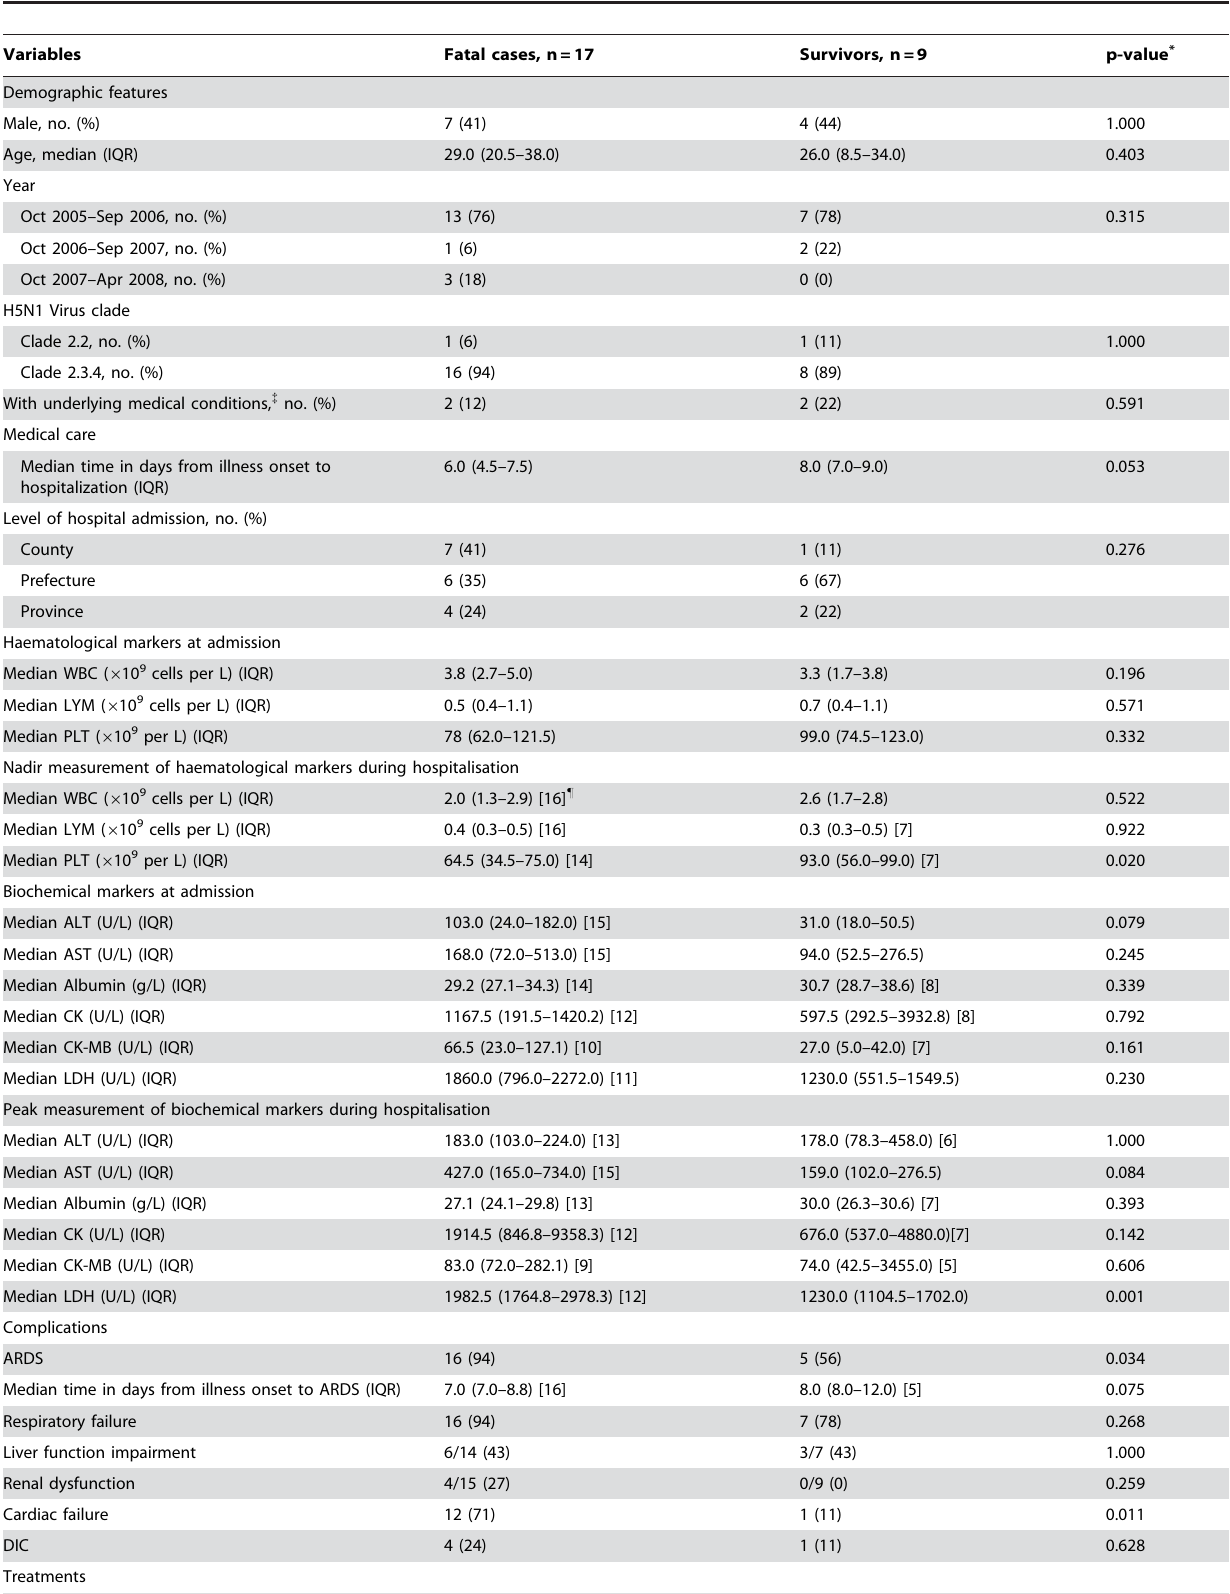
Table 4. Comparison of demographic and clinical features of 17 fatal and 9 nonfatal H5N1 cases,